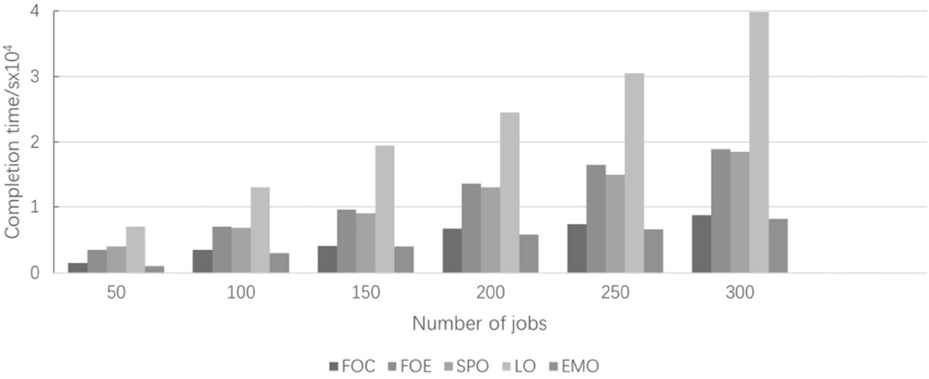
Figure 5. The completion time of the task scheduling algorithm. Table 3. Comparison analysis table of throughput and latency metrics.